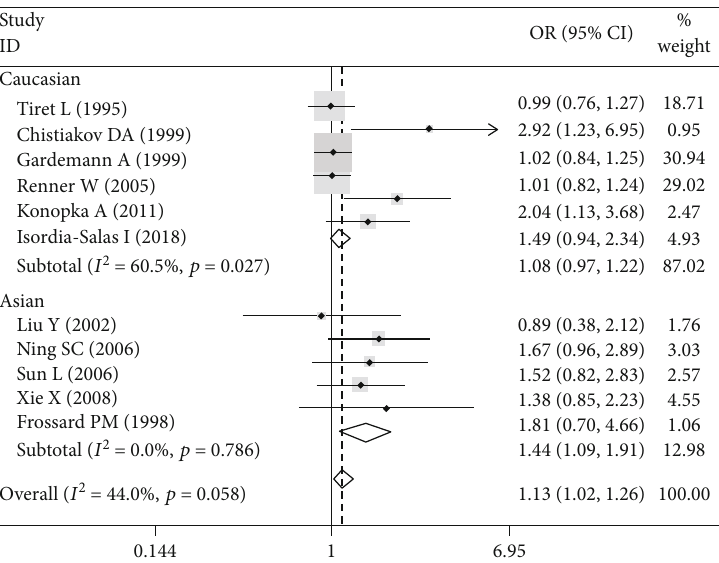
Figure 2: Forest plot of AGT p.Thr174Met polymorphism associated with myocardial infarction strati fi ed by ethnicity using a dominant genetic model (TM+MM vs. TT).